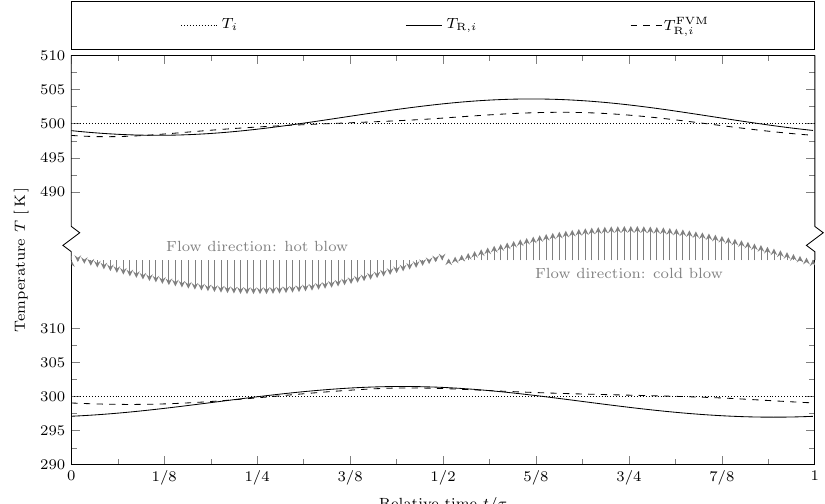
T EEn -regenerator model (solid lines) Figure 12. Contact point temperatures T R,H and R,L of the compared to the contact point temperatures of a finite volume benchmark regenerator model T FVM R,H and T FVM R,L (dashed lines) for the internally reversible case Σ S R : = 0 with oscillating system pressure. The constant temperatures of the adjacent gas reservoirs T H and T L are plotted with dotted lines. Due to the pressure oscillations, the finite volume benchmark temperatures T FVM R,H and T FVM R,L exceed T T H and proceed below L , respectively. The amplitude of contact point temperature oscillations is slightly overestimated by the EEn -regenerator. Nevertheless, the regenerative behavior under pressure oscillations is well approximated, despite the fact that the EEn -regenerator model has only three degrees of freedom and significantly lower numerical